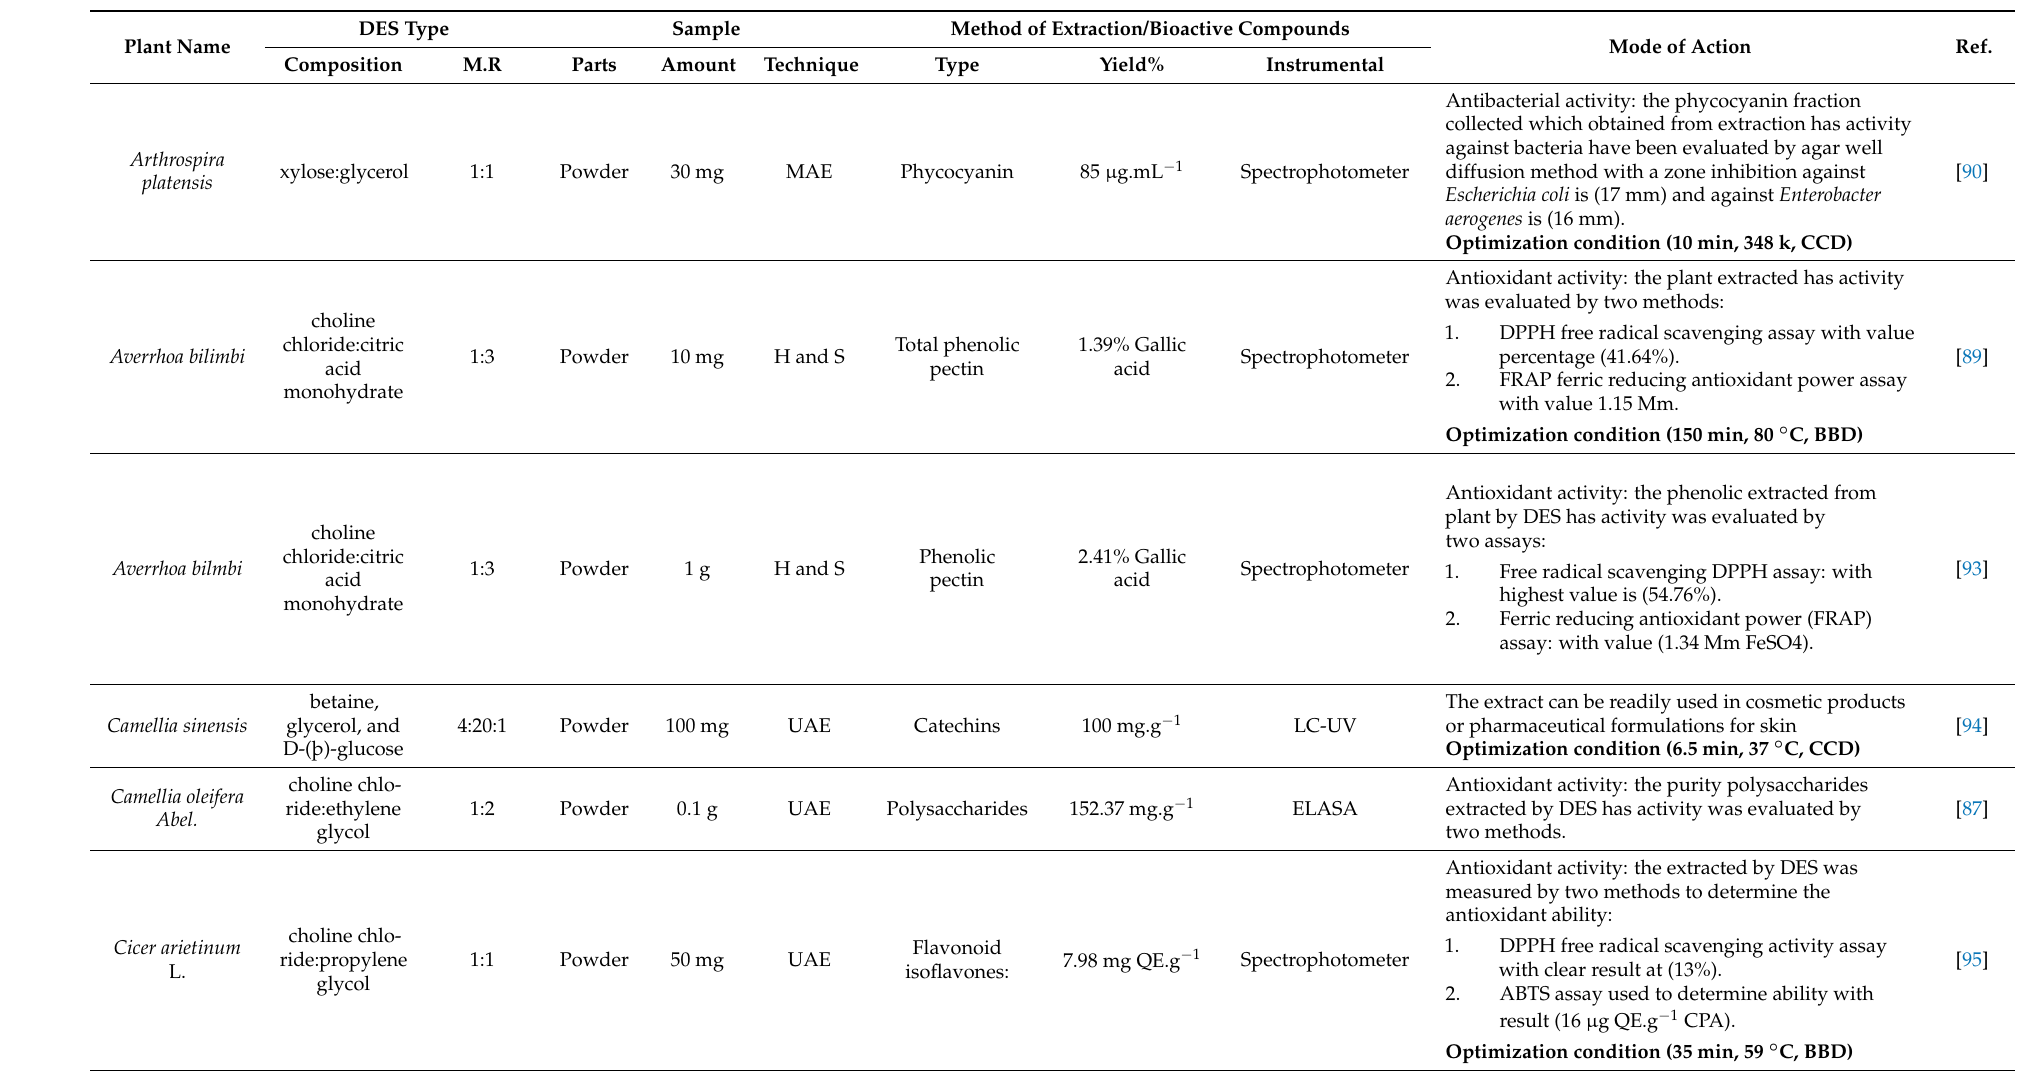
Table 2. Summary the application of the DES in medicinal plants